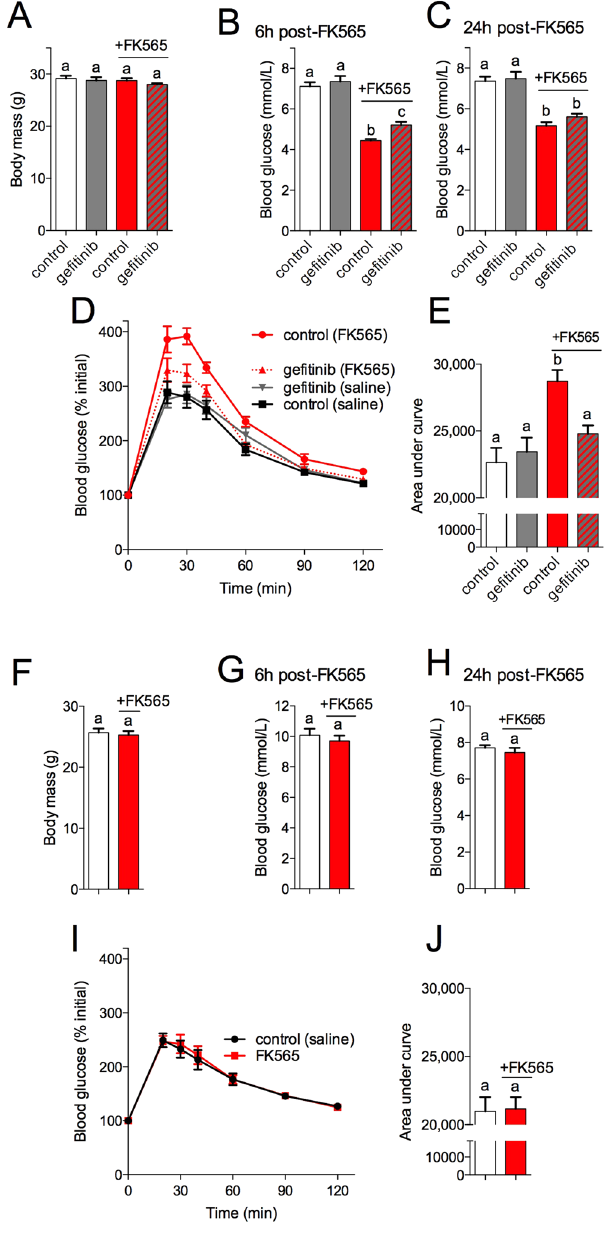
Figure 7. TKI gefitinib inhibits RIPK2-mediated dysglycemia in vivo . WT mice pre-treated with TKI gefitinib (100 mg/kg) or methylcellulose vehicle for 4 days before injection of a NOD1 ligand and metabolic testing. Body Mass ( A ) and fasting blood glucose at 6 h ( B ) and 24 h ( C ) after injection of WT mice with FK565 (10 μ g, i . p .) in gefitinib and vehicle pretreated mice, n = 9–12. Percentage change in blood glucose over time ( D ) and area under the curve ( E ) of a glucose tolerance test (2.0 g/kg glucose, i . p .) 24 h after injection of WT mice with FK565 (10 μ g, i . p .) in gefitinib and vehicle pretreated mice, n = 12. Body Mass ( F ) and fasting blood glucose at 6 h ( G ) and 24 h ( H ) after injection of RIPK2 − / − mice with FK565 (10 μ g, i . p .), n = 6–9. Percentage change in blood glucose over time ( I ) and area under the curve ( J ) of a glucose tolerance test (2.0 g/kg glucose, i . p .) 24 h after injection of RIPK2 − / − mice with FK565 (10 μ g, i . p .), n = 9. Values are mean ± SEM. Different letters assigned to each condition (a, b, c) denote statistical differences between groups (p <